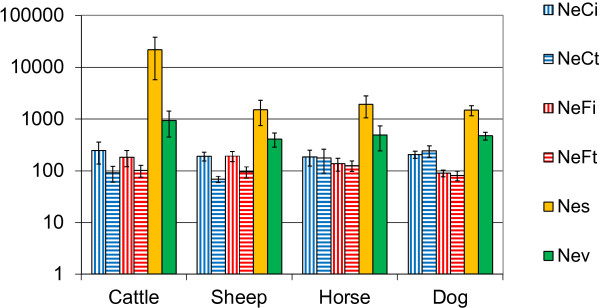
Average effective population sizes according to species and methods, using a logarithmic scale. Standard errors are indicated.